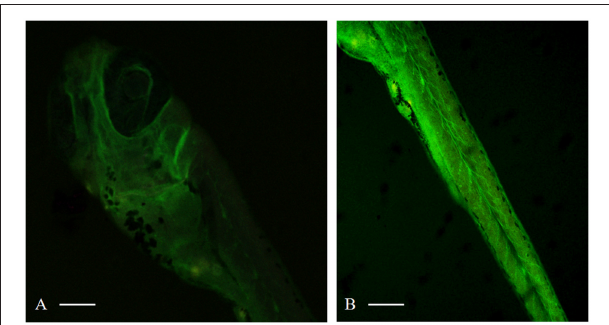
FIGURE 3 | Western blotting analysis for evaluation the effects of exposure to nanomaterials. The MTs level, in untreated samples and in larvae exposed to nanomaterials before (Time 0) and after a 12 days (Time 12) dipping in aquatic environment was evaluated. The data are expressed as mean ± SEM. Statistical analysis was carried out by ANOVA test. A p -value of less than 0.05 ( p < 0.05) was accepted as statistically significant between experimental and control